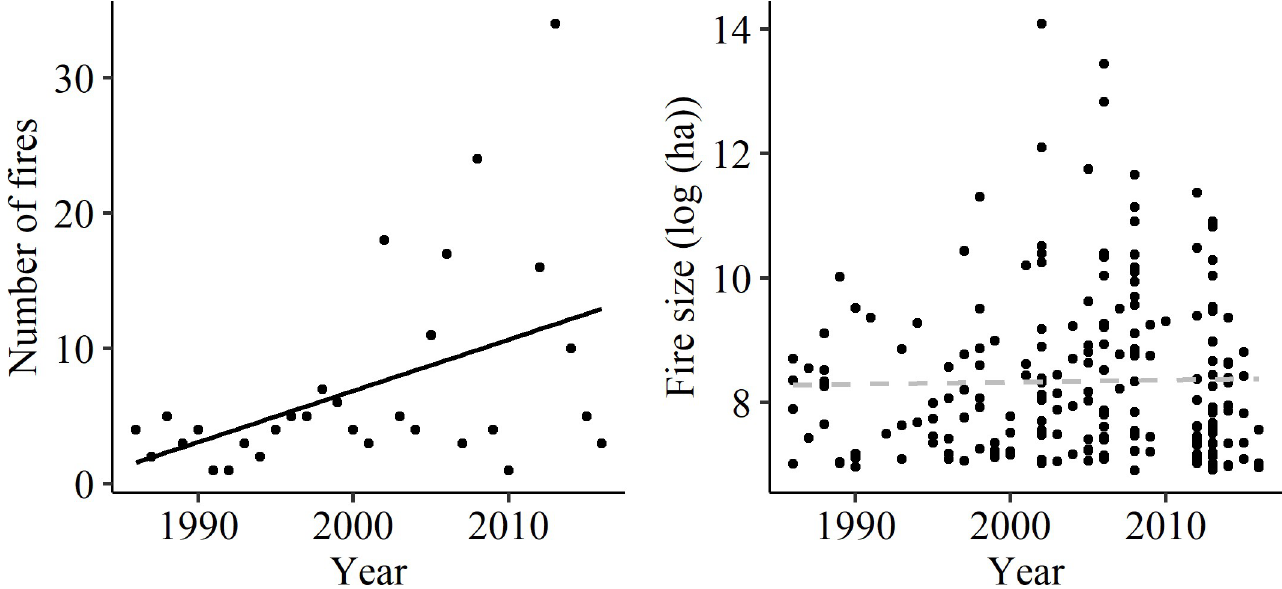
Fig 2. Changes in the number of fires per year and fire size between 1987 and 2017. Data includes all wildfires � 1000 ha from DEWLP fire history dataset (n = 211) [64]. Solid black line indicates significant relationship (P < 0.05), dashed grey line indicates no significant relationship.